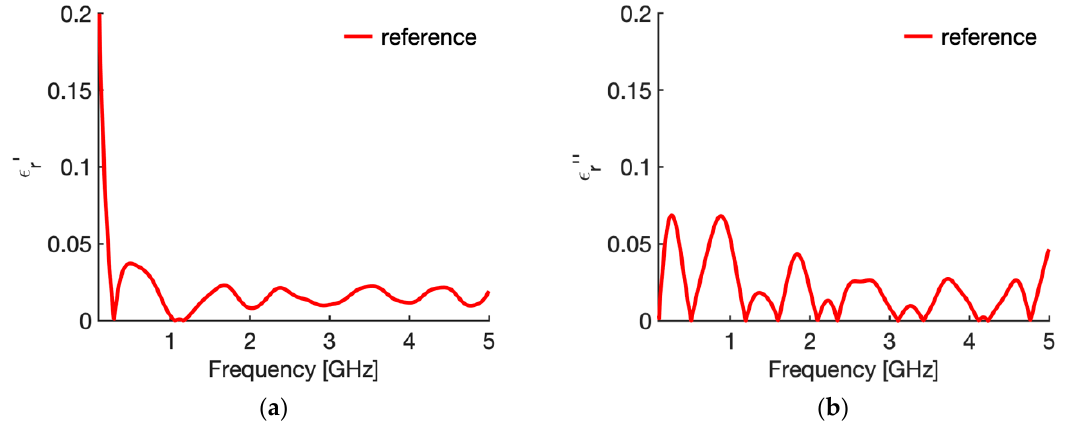
Figure 4. Percentage errors in the evaluation of the relative complex permittivity of liver at 25 °C through the reflection arrangement of the open probe technique ( a ) real part; ( b ) imaginary part.